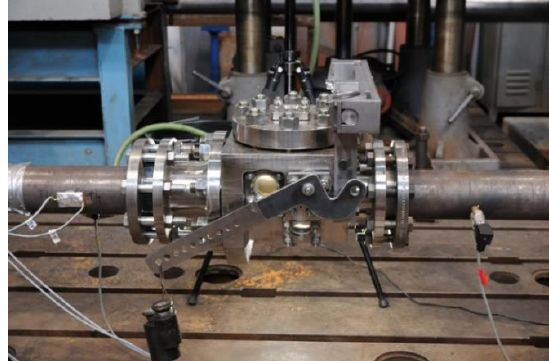
Fig. 8. Axial check valve – Top-entry